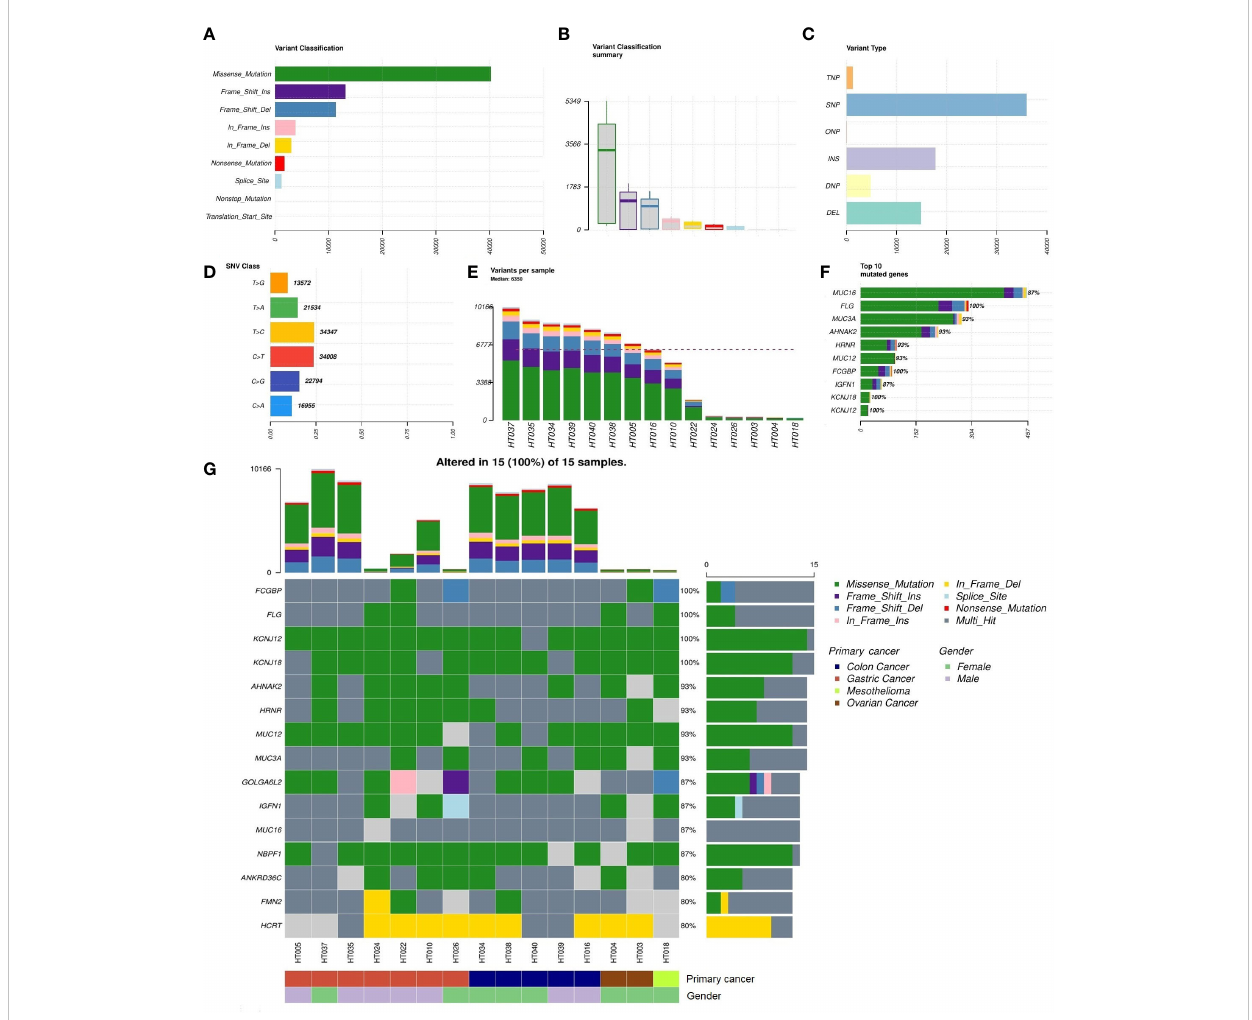
FIGURE 2 Summary of the non-synonymous mutational landscape ( n = 15 patients). (A, B) Classi fi cations of non-synonymous mutations (i.e., single-nucleotide variants (SNVs) and insertions/deletions (INDELs)). (C) Types of non-synonymous mutations. (D) Frequencies of transition and transversion events in SNVs. (E) Total mutational loads in each tumor sample. (F) The top 10 genes with the highest rate of mutation. (G) Oncoplot showing the top 15 most frequently mutated genes with detailed annotations in each tumor